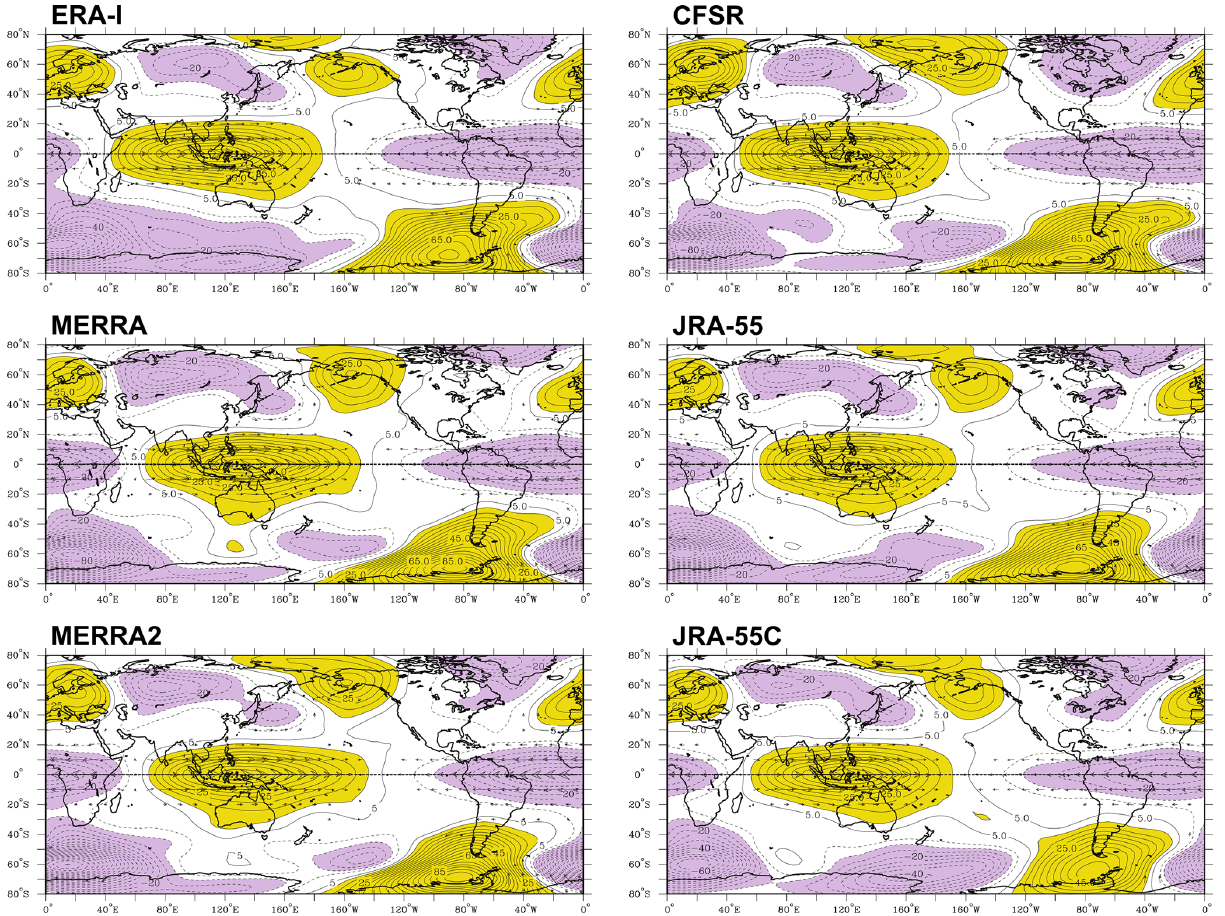
Figure 4. Horizontal-wind (arrow) and geopotential perturbations (shading) projected onto the principle component time series of the first EOF modes for Kelvin waves at 50hPa in each reanalysis. The EOFs for Kelvin waves are calculated using 2–25d filtered eastward- propagating zonal winds (see the text). The winds are shown at the locations where they are statistically